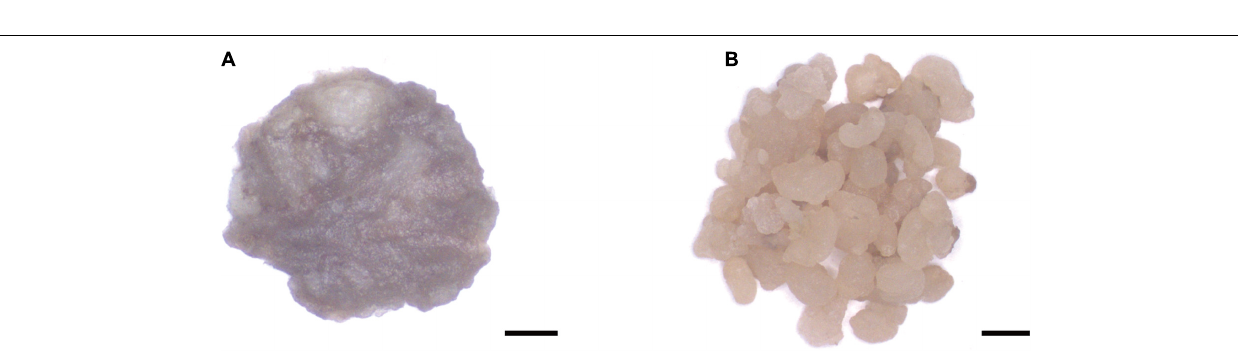
FIGURE 2 | The morphology of Tripterygium wilfordii CMCs and DDCs. (A) CMCs were mostly aggregated by small cell groups. Scale bar, 2 mm. (B) DDCs were gathered with large cell groups. Scale bar, 2 mm.